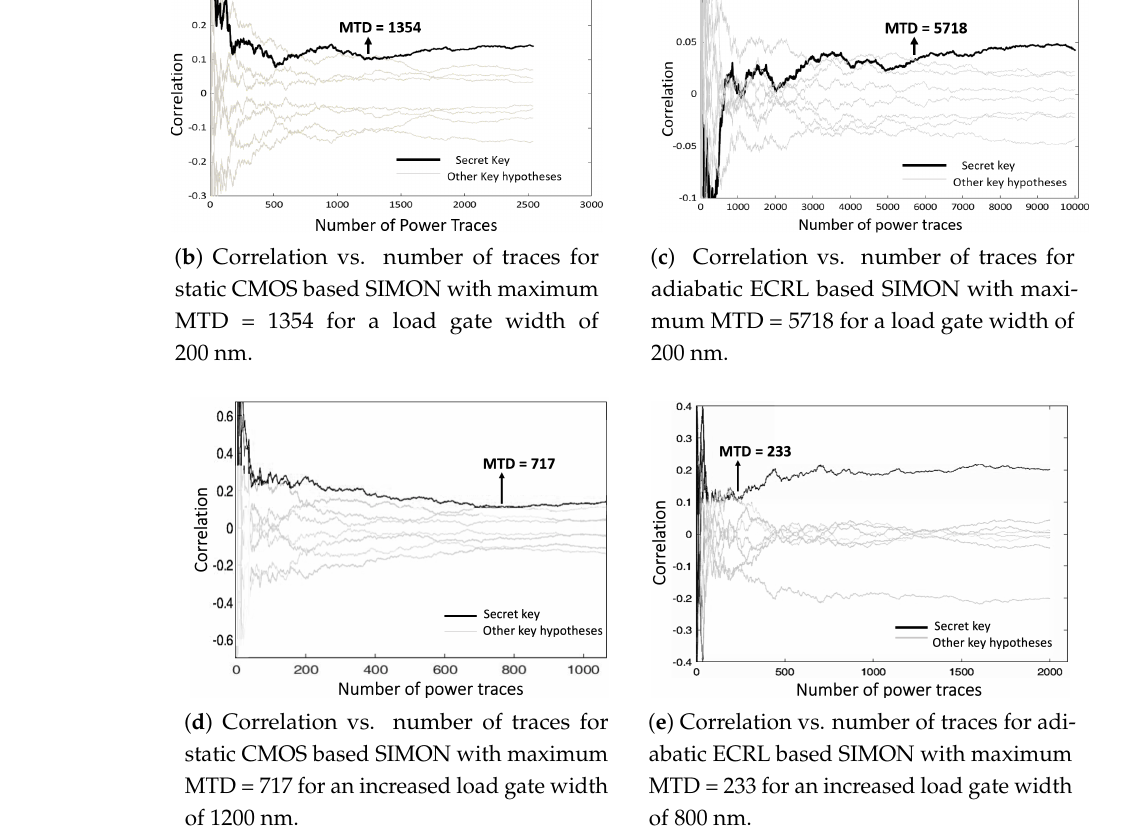
Figure 9. Correlation power analysis (CPA) attack results.